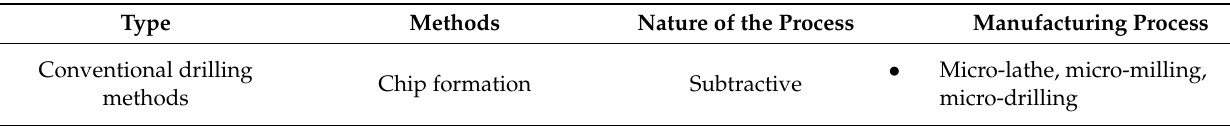
Table 1. Commonly used drilling methods for manufacturing miniature